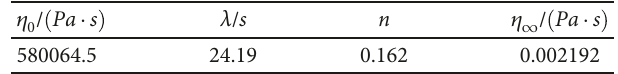
Figure 2: Simulation model and boundaries. Table 1: Bird – Carreau model